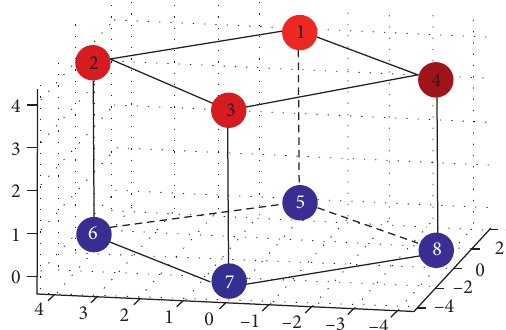
Figure 2: In an undirected graph, the multiagent system of eight nodes.